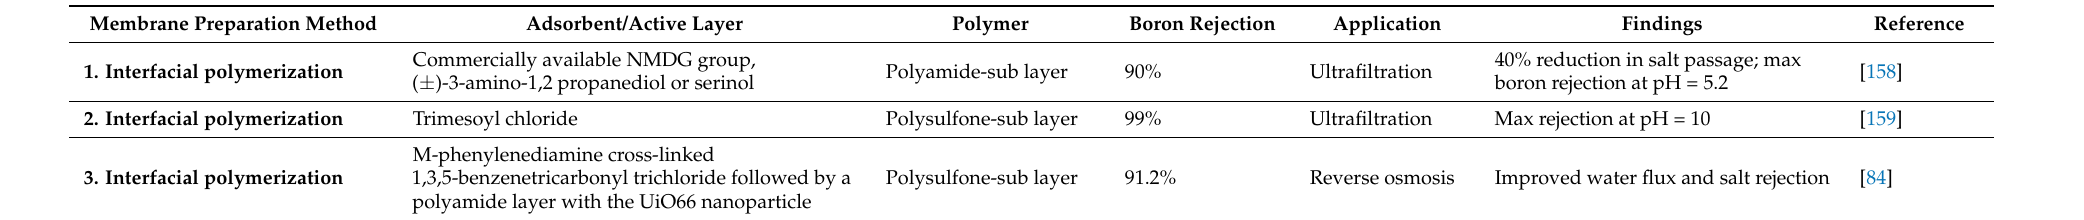
Table 7. Studies about dual-layered flat sheet membranes for boron